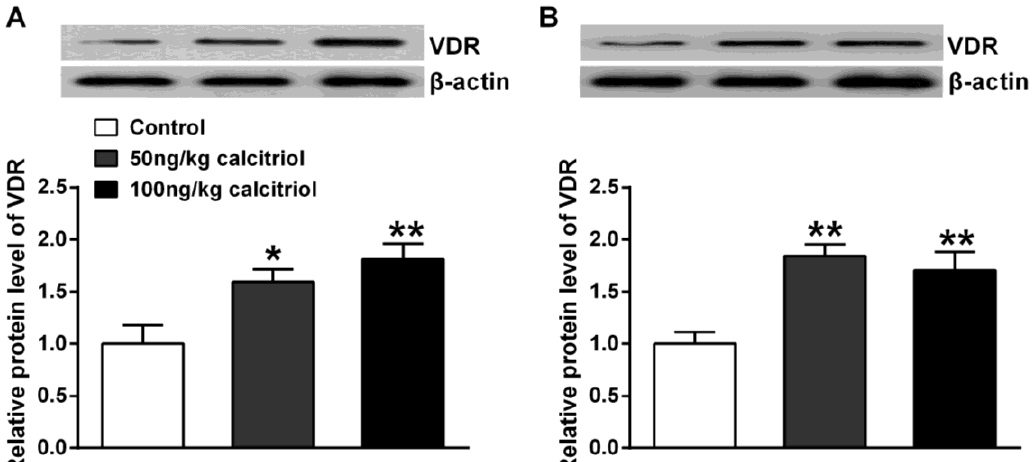
Figure 1. Effect of chronic calcitriol administration on protein expression of vitamin D receptor (VDR) in prefrontal cortex ( A ); and hippocampus ( B ). Relative expression values were shown as a normalized ratio to β-actin protein level. Data are means ± SEM ( n = 4). * p < 0.05, ** p < 0.01 compared to control